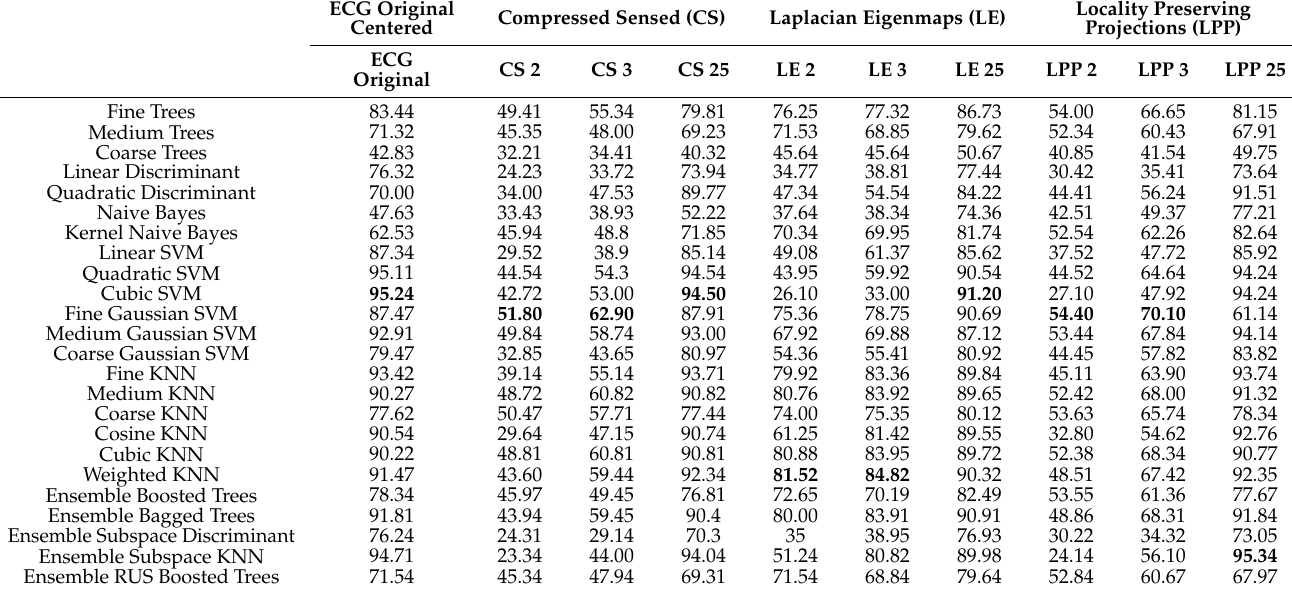
Locality Preserving Projections